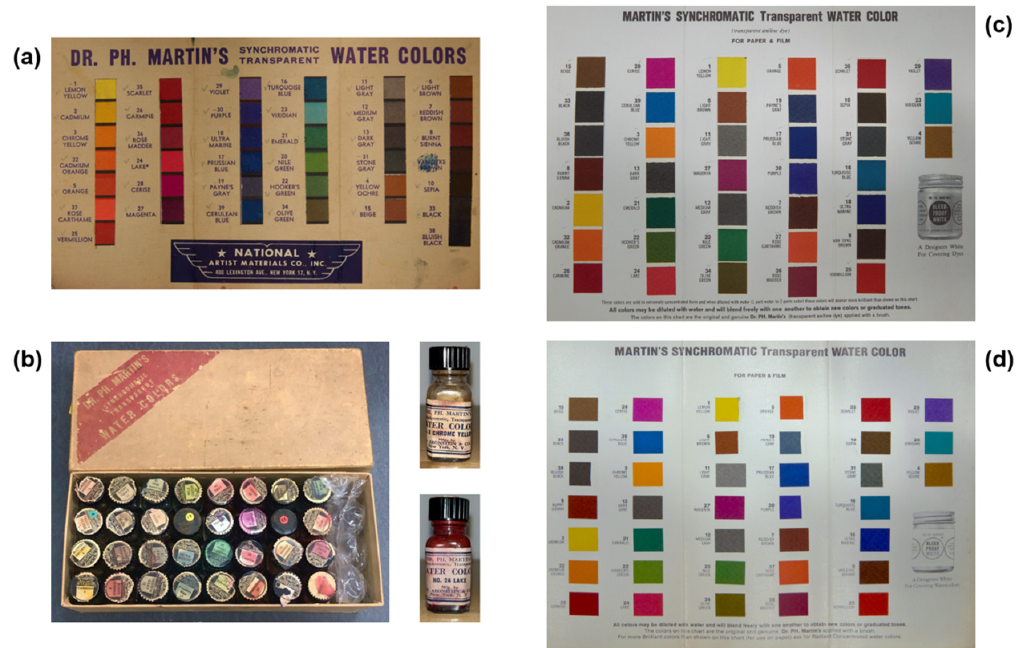
Figure 2. Different sets and brochures used for the identification of dyes in Dr. Ph. Martin’s